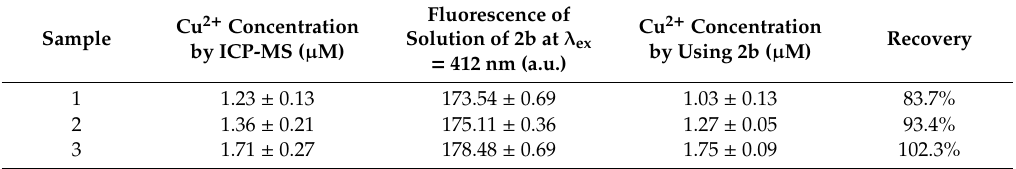
Table 5. Determination and recovery values of Cu 2 + in soil samples using both ICP-MS ( µ M) and 2b ( µ M).